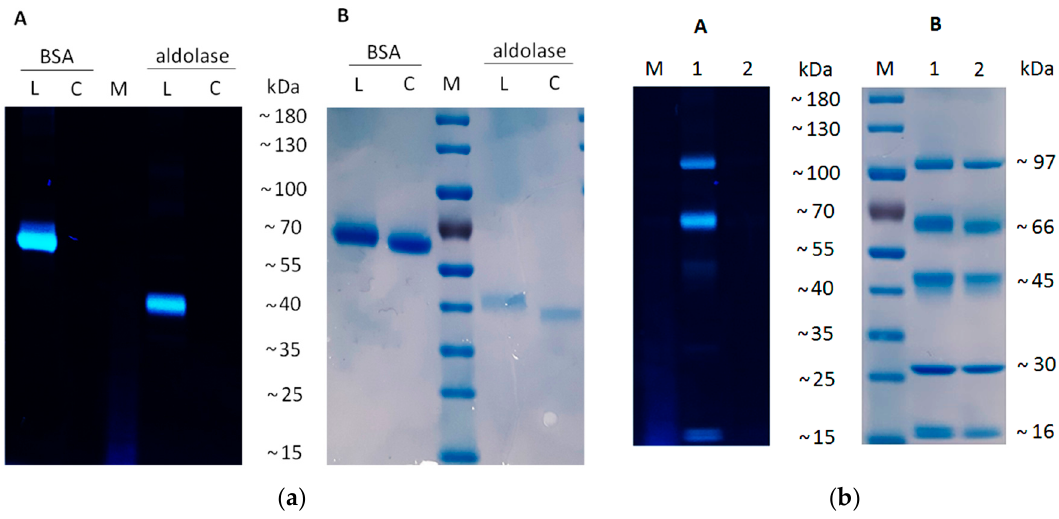
Figure 7. ( a ) Electropherograms of BSA (~66 kDa) and aldolase (~40 kDa) with (L) or without (C) labelling with 9b ; ( b ) electropherograms of standard mixture of five different proteins with (L) or without (C) labelling with 9b . Standard mixture of proteins contained phosphorylase b (~97 kDa), BSA (~66 kDa), ovalbumin (~45 kDa), carbonic anhydrase (~30 kDa), and recombinant KNOX-HD protein (~16 kDa). Proteins were visualized using a UV transilluminator ( A ) and Coomassie Brilliant Blue staining ( B ). M—molecular weight marker.